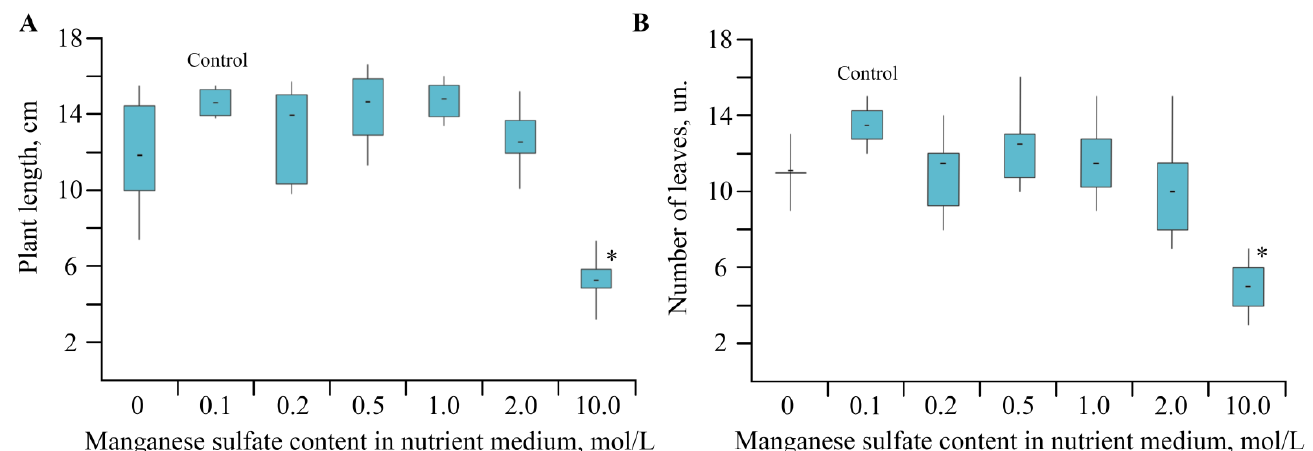
Figure 2. ( A , B ) The biometric parameters depending on Mn sulfate concentration in nutrient medium; * p ≤ 0.01 compared to the control according to the Mann–Whitney test.